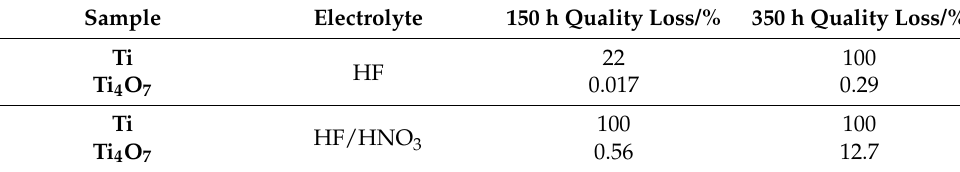
Table 2. Comparison of corrosion resistance between Ti 4 O 7 and Ti [58].